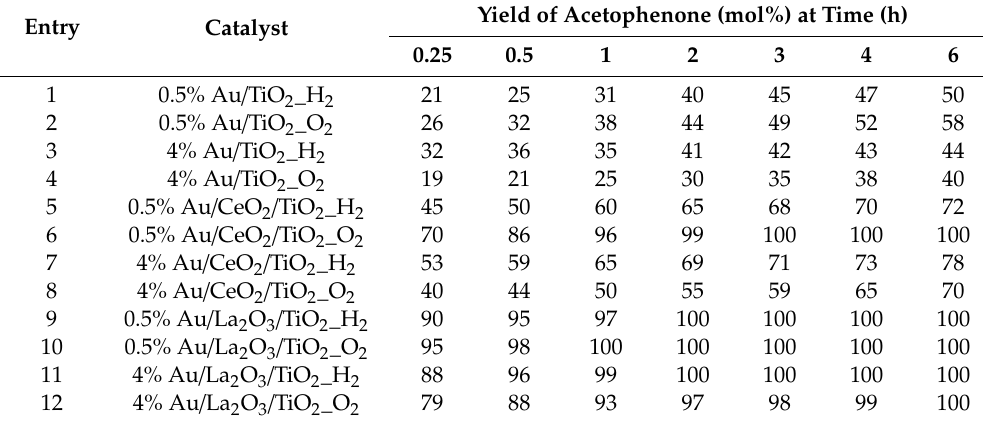
Table 5. Catalytic results of aerobic oxidation of 1-phenylethanol 1 .